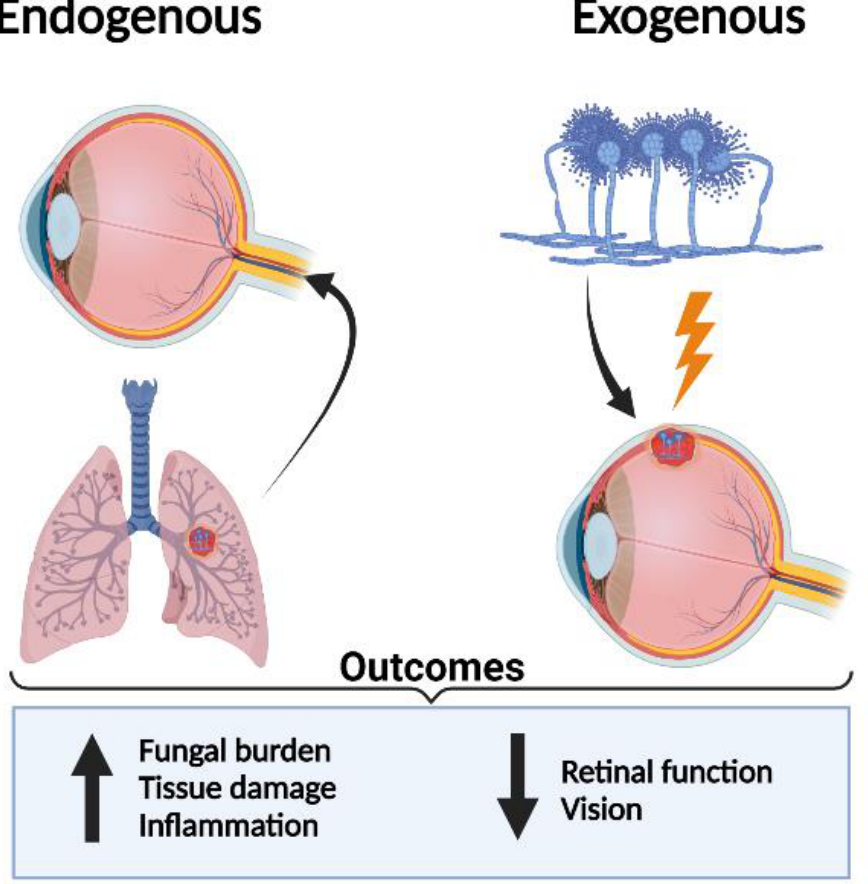
Figure 1. Fungal spores are inhaled from the environment into the lung resulting in lung Aspergillosis. As the disease progresses, spores are released into the bloodstream and disseminate to other organs, including the eye, resulting in endogenous Aspergillus endophthalmitis. Fungal hyphae eventually cross the blood–retinal barrier and penetrate inside the eye. In the case of exogenous endophthalmitis, Aspergillus spores enter the eye during ocular trauma.